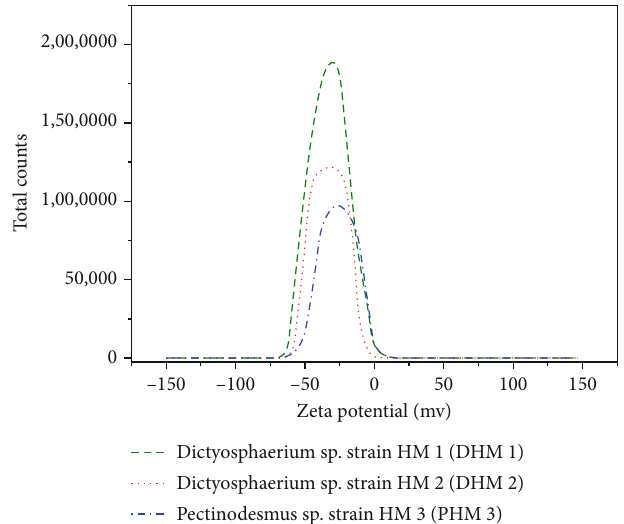
Figure 5: Zeta Potential of algal strains DHM1, DHM2, and DHM3.